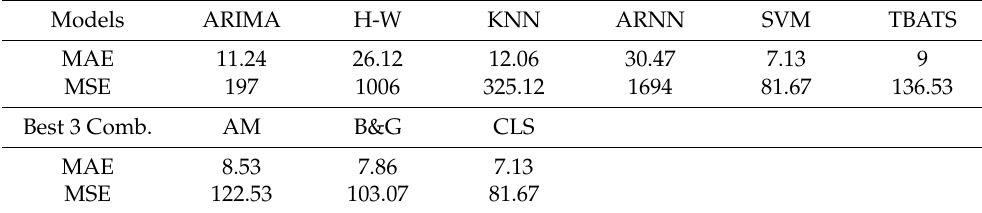
Figure 10. Cluster 2: three last days of historical data plus one-day predictions and real values ( left ). On the ( right ), a close-up of the predictions and real values is shown. Table 3. MAEs and MSEs for each model in Cluster 2 for one-week historical and one-day predictions and for the different combinations of the best three models.